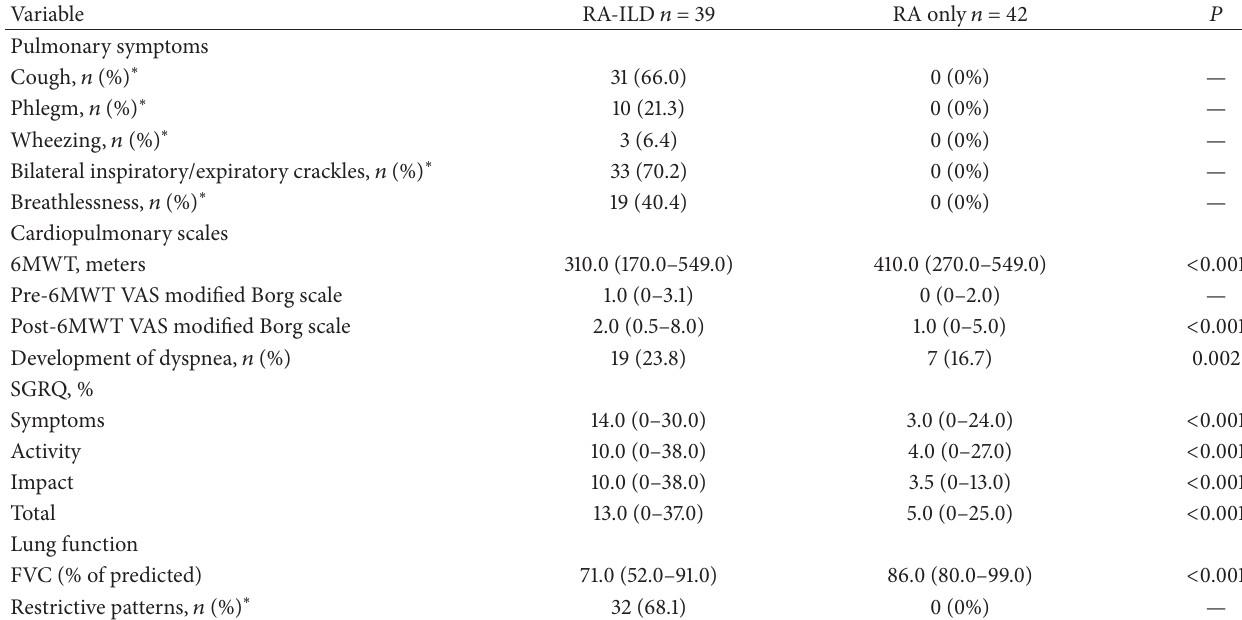
Table 2: Comparison of cardiopulmonary scales and Saint George Respiratory Questionnaire between patients with rheumatoid arthritis and interstitial lung disease (RA-ILD) and patients with RA only.